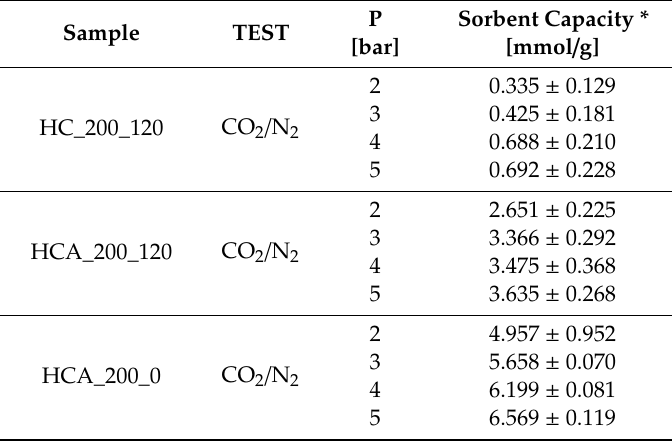
Table 3. CO 2 sorbent capacity.